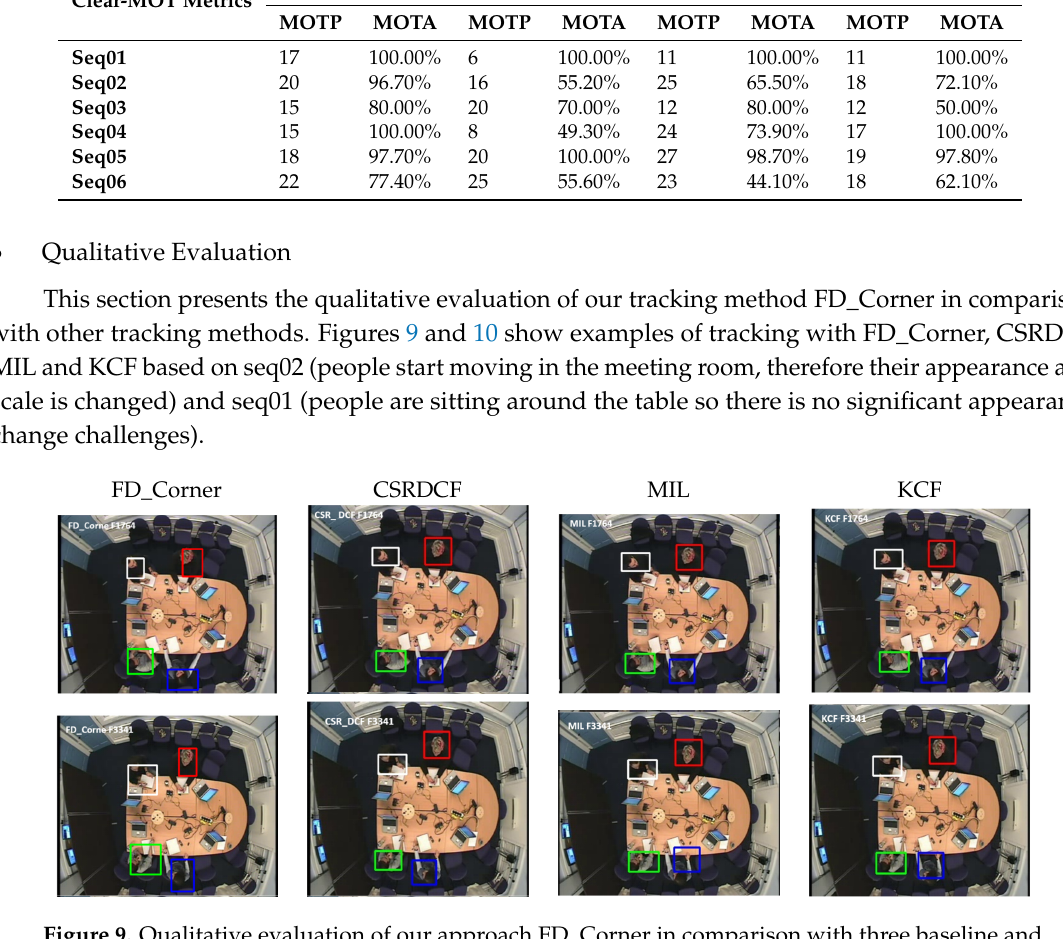
Figure 9. Qualitative evaluation of our approach FD_Corner in comparison with three baseline and state of art trackers. Tracking results for two examples from the meeting video sequence 01 shows that all trackers exhibit relatively good performance in a sequence whith no major appearance